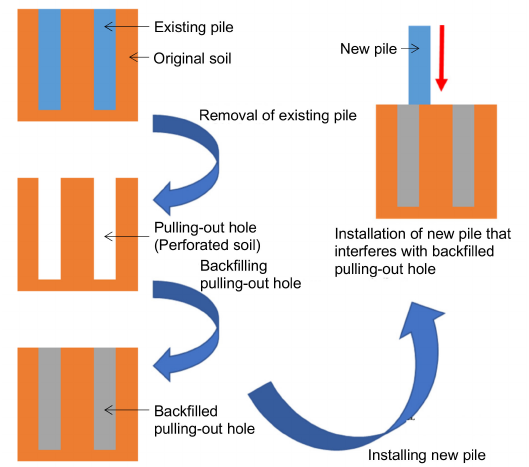
Figure 2. Typical flow from removal of existing pile to installation of new pile at that